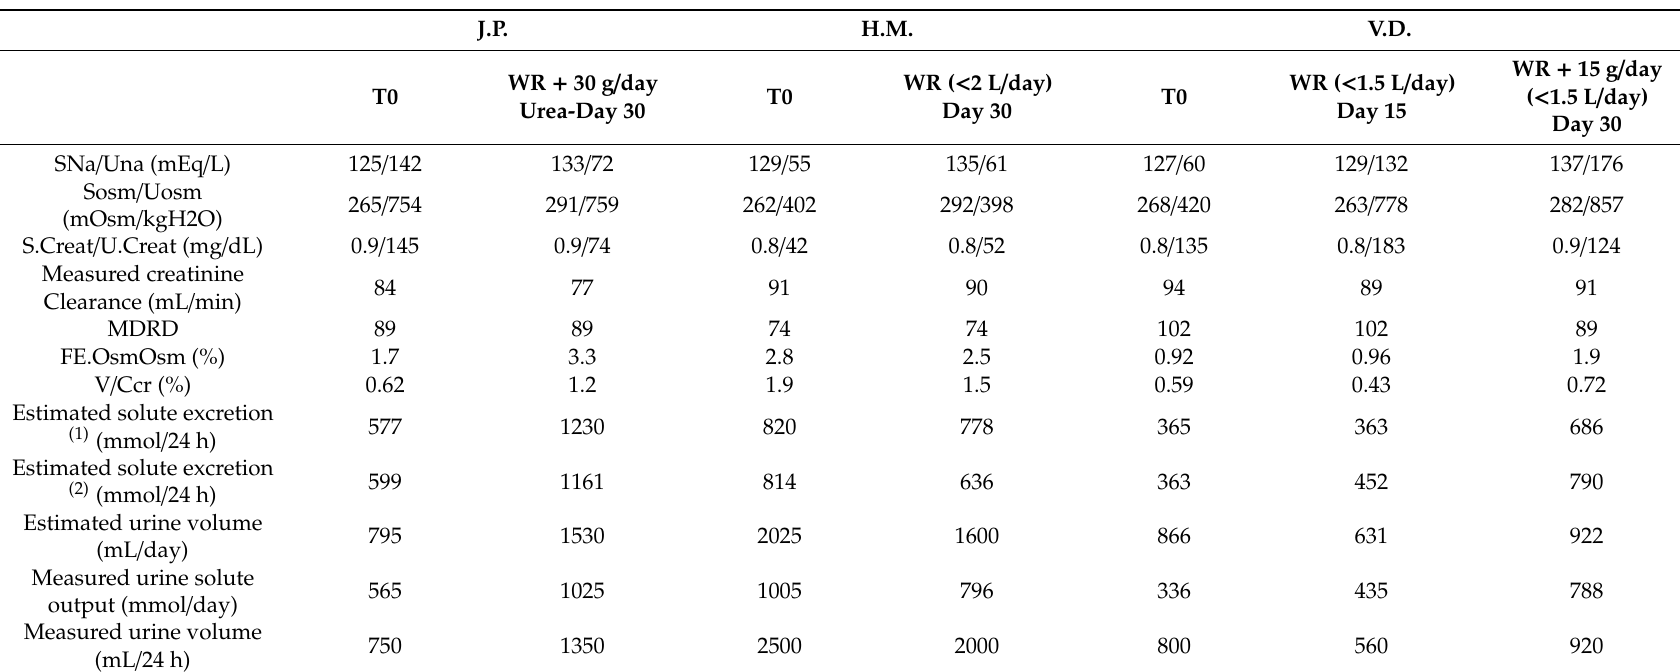
Table 2. Estimation of fluid and solute intakes in three patients with hyponatremia related to SIADH and treated by water restriction (WR) with or without urea (solute excretion) where calculated by two di ff erent methods (1),(2) . J.P. H.M.